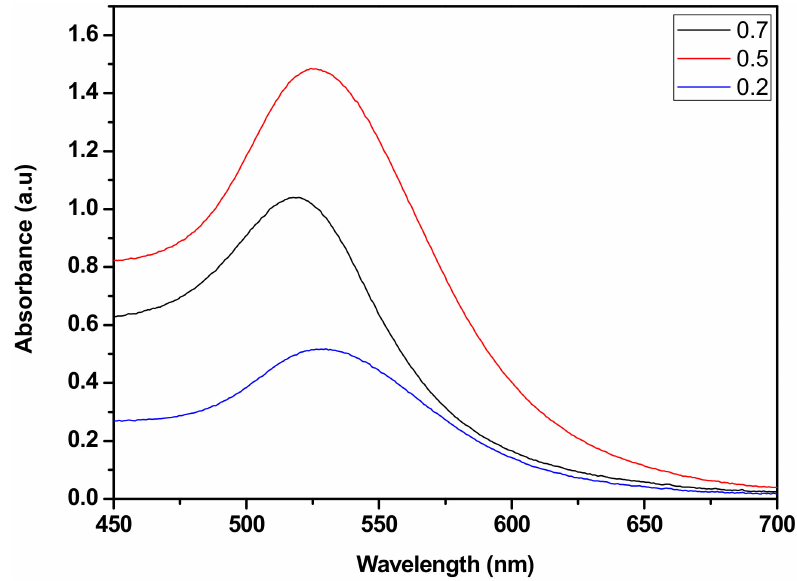
Figure 3. The UV-Vis spectra of the samples with various citrate/metal precursor ratios. AuNPs were synthesized by the classic Turkevich method with varying citrate/gold salt ratios [26]. Figure 4 shows TEM images of the various samples (ratios: 0.7, 0.5 and 0.2) with their respective size distribution histograms. The TEM images revealed that the samples had particle sizes of 14 (0.7), 30 (0.5) and 40 nm (0.2). The TEM showed monodispered AuNPs in line with the single peak observed from the UV-Vis spectrum. Interestingly, the shape of the AuNPs became increasingly irregular with a decrease in the citrate/gold salt ratio. A limited concentration of citrate molecules resulted in a formation of an oval shape and/or other irregular structures (Figure